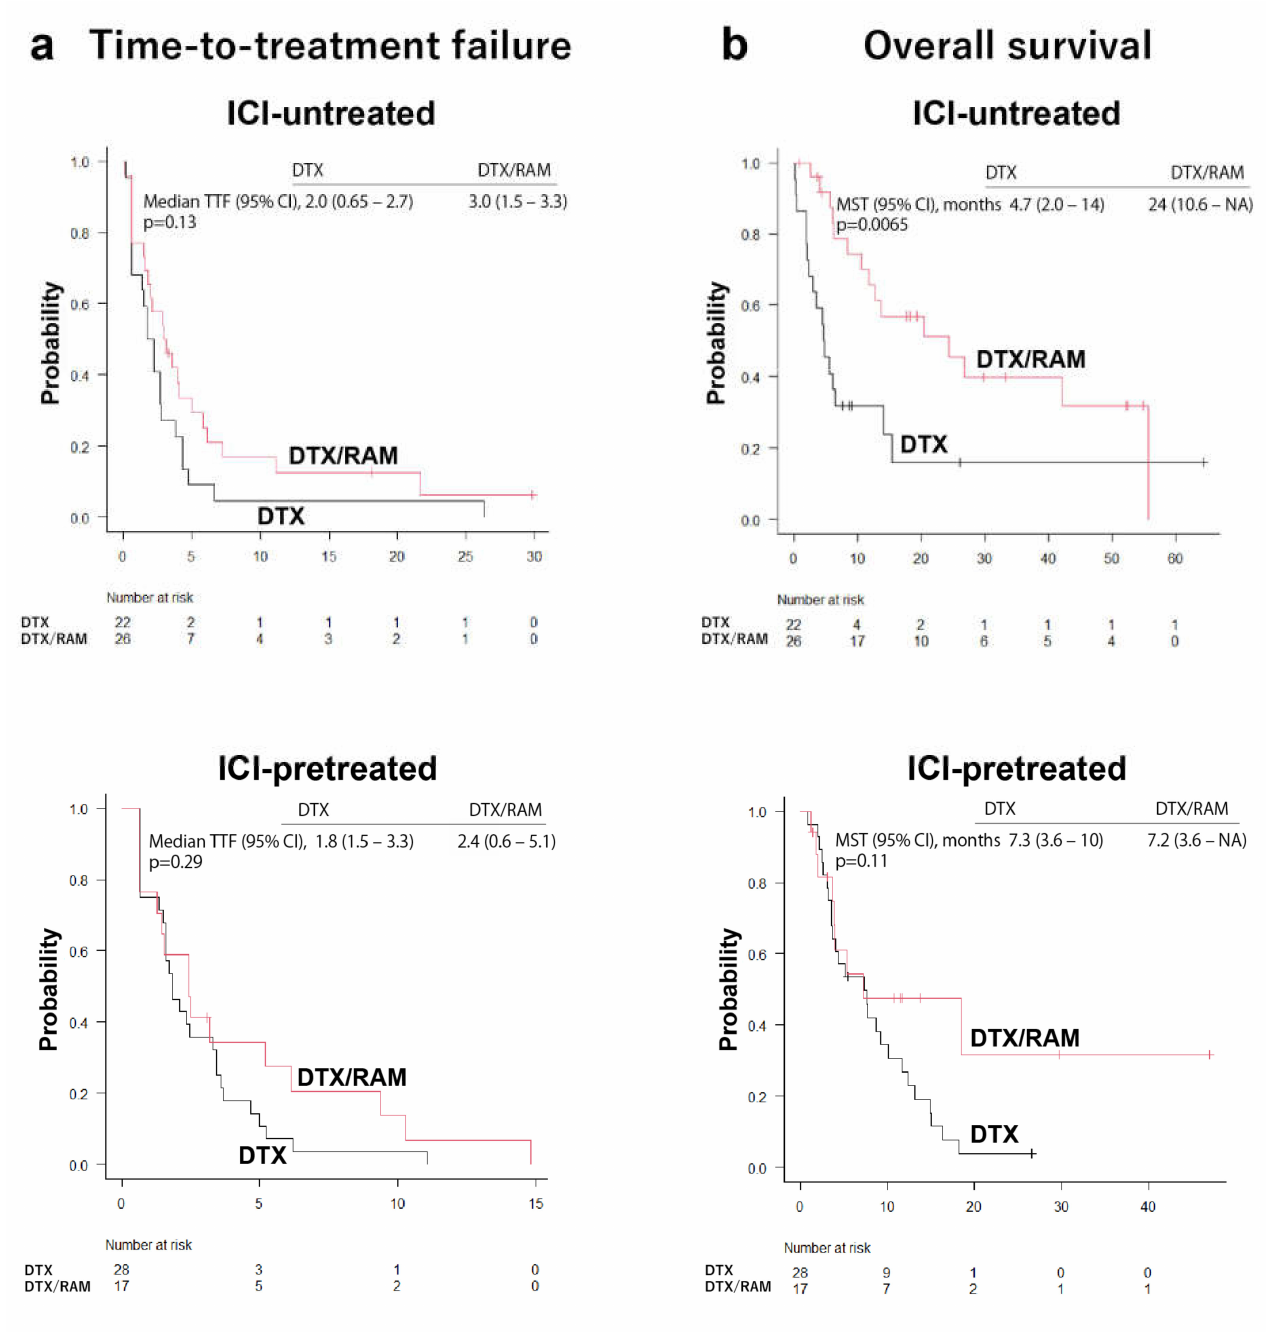
Figure 3. Comparative analysis of docetaxel alone and combination therapy of docetaxel and ramu- cirumab in all immune checkpoint inhibitor-pretreated and -untreated patients. The time-to-treatment failure (TTF) was not significantly different between docetaxel (DTX) and docetaxel and ramucirumab (DTX/RAM) treatment groups, neither in the immune checkpoint inhibitor (ICI)-pretreated group nor in the immune checkpoint inhibitor (ICI)-untreated group. There was a significant difference in overall survival between DTX and DTX/RAM groups in the ICI-untreated group. Patients treated with DTX/RAM have a longer survival time than those treated with DTX in the ICI-pretreated group, although the difference was not significant. MST, median survival